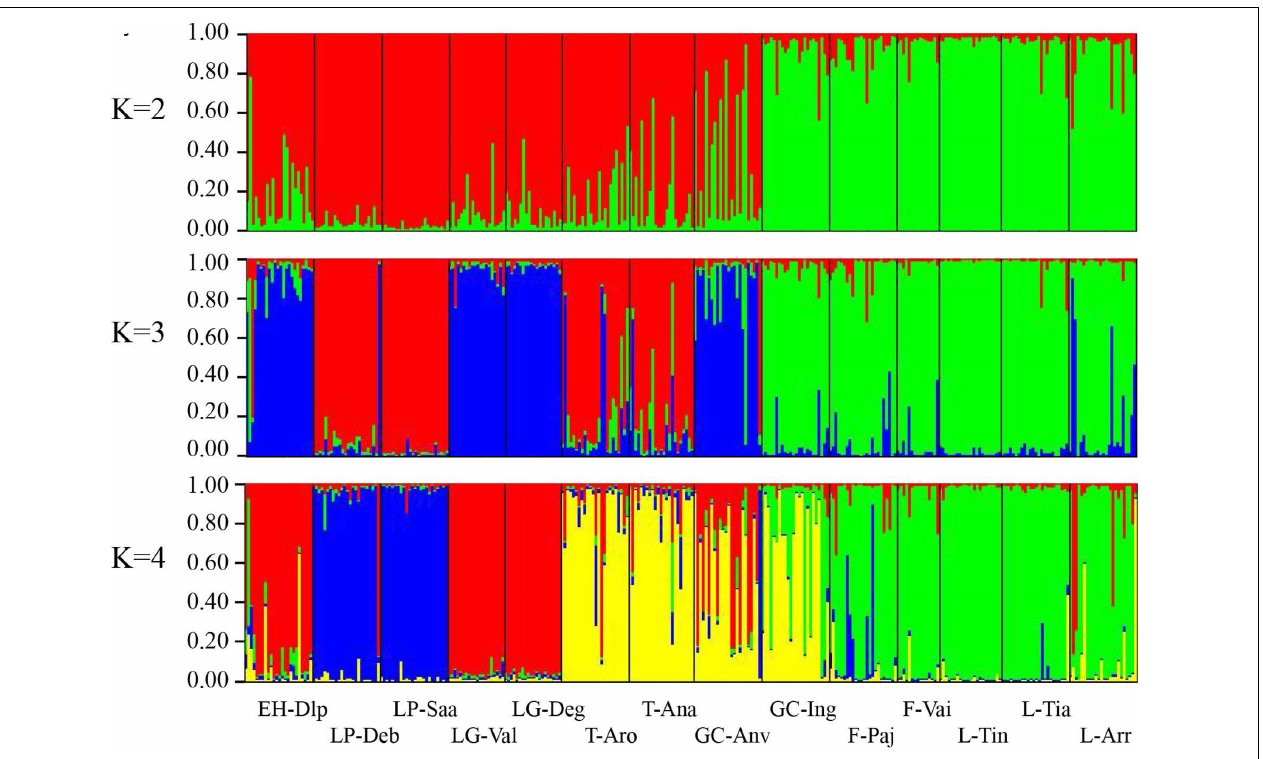
FIGURE 3 | Genetic structure of Kleinia neriifolia revealed with microsatellite markers using STRUCTURE analyses. Individual proportion of the membership were showed when two, three, or four clusters defined by STRUCTURE analyses, respectively. Population codes are same as that in Table 1 .